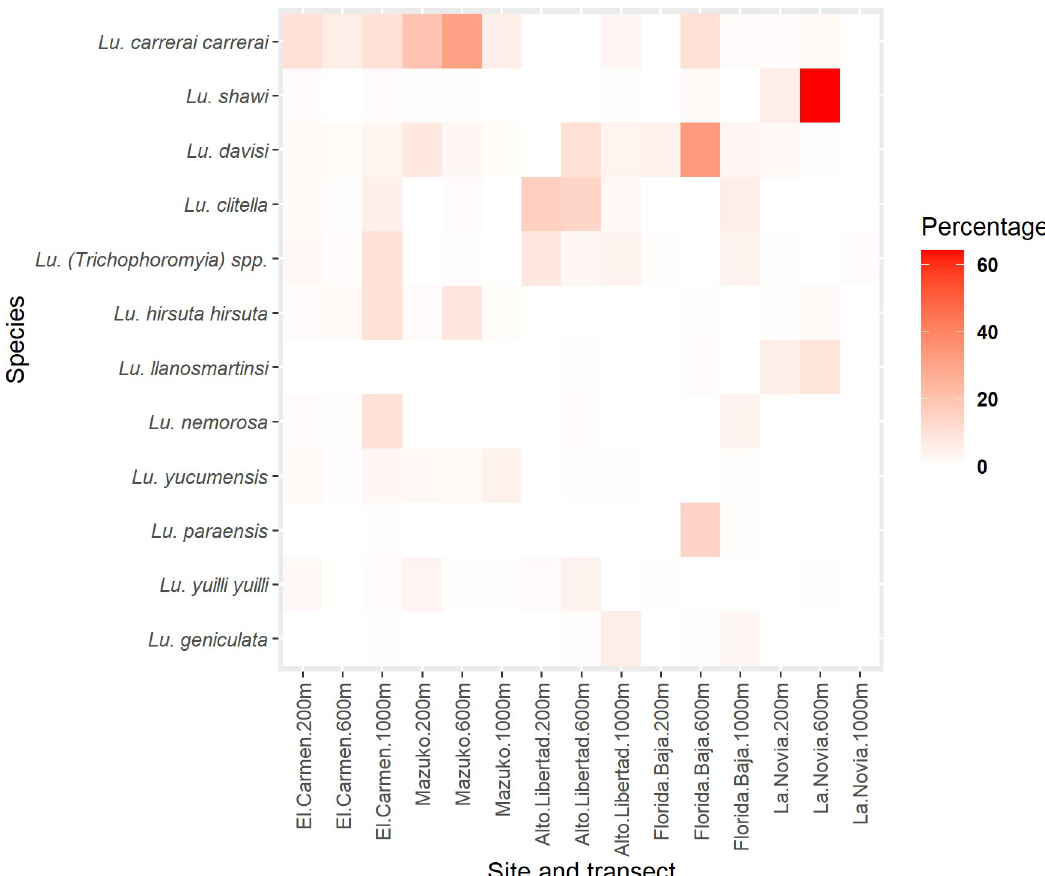
Fig 5. Percentage of collected sand fly species by transect and location. The figure shows the percentages of the most abundant species per transect per each site. Differences were found according to site and transect within and between locations. Statistical significant differences in Shannon diversity indexes between transects of the same location were found in El Carmen (200 m/1,000 m and 600 m/1,000 m), Alto Libertad (200 m/1,000 m and 200 m /600 m) and La Novia (200 m/600 m) (FDR adjusted p < 0.05).